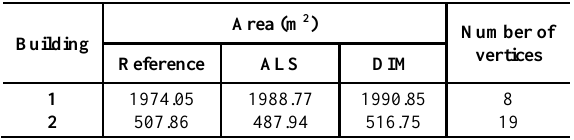
Table 3. Characteristics of the selected buildings.